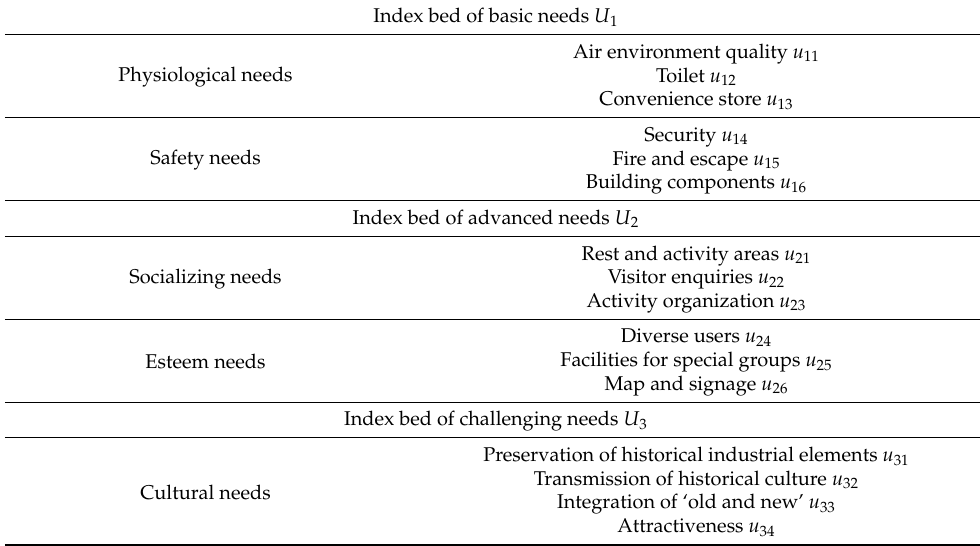
Table 2. Evaluation factor system of reused old industrial buildings (by author, 2022).